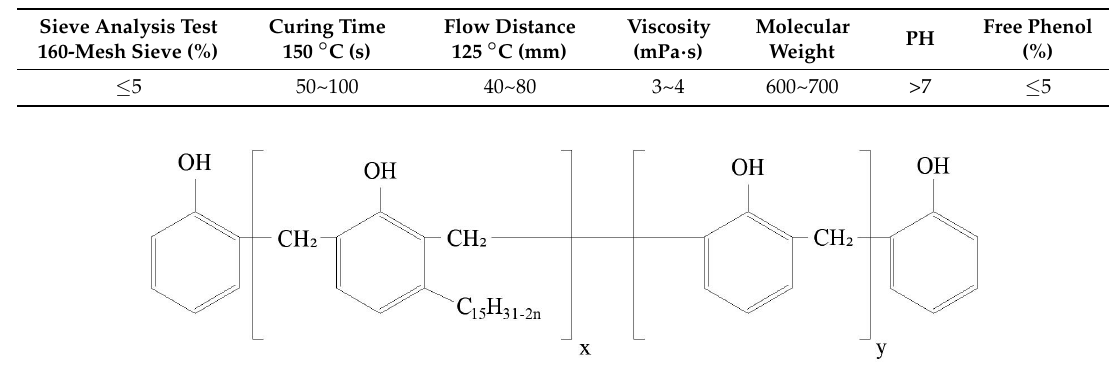
Figure 1. The general chemical structure of used phenolic resin.